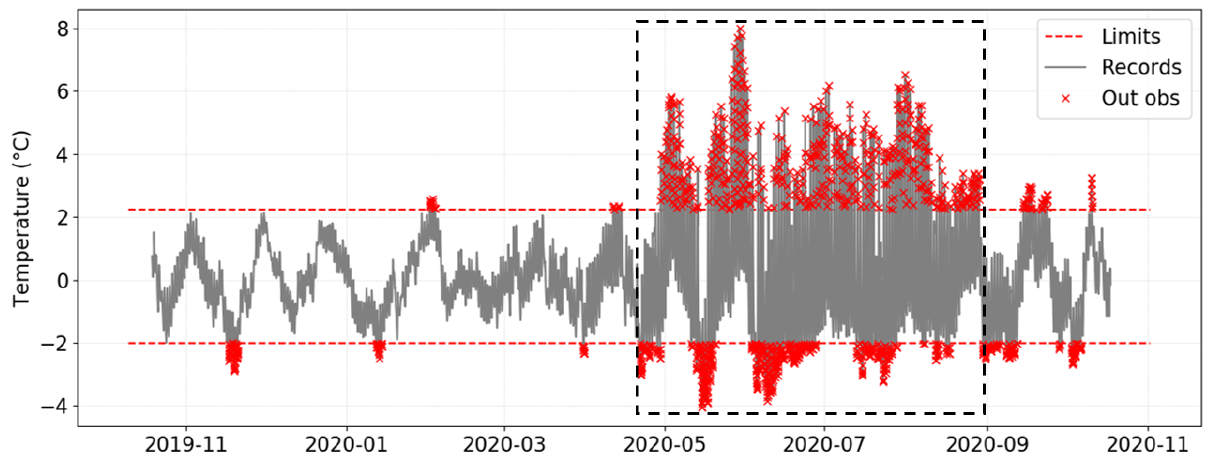
Figure 4. Short-term fluctuations of temperature for data-logger B2 (i.e., deviations with respect to the seasonal trend). Security limits according to EN 15757:2010 are depicted as horizontal lines in red. The box in dashed lines (same as Figure 3) indicates the period with a higher frequency of short-term fluctuations.